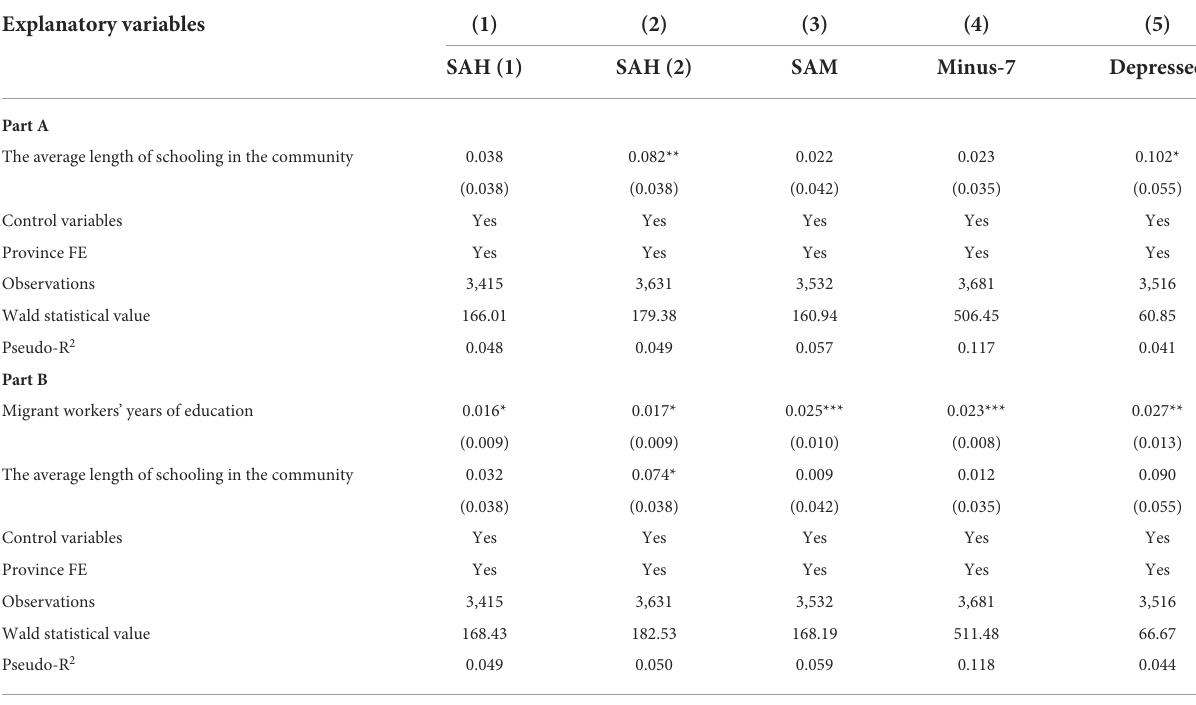
TABLE 5 Instrumental variable test (2): exogeneity test results.